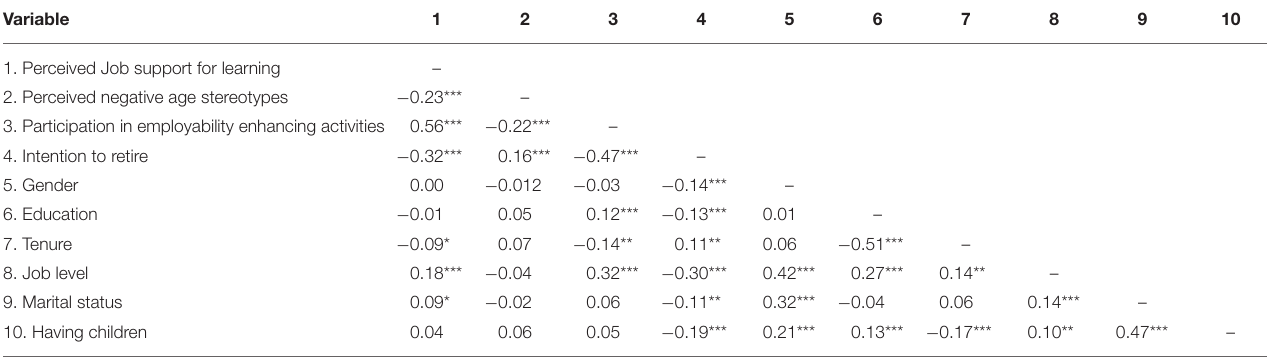
TABLE 2 | Correlation matrix ( N = 2,082). Variable